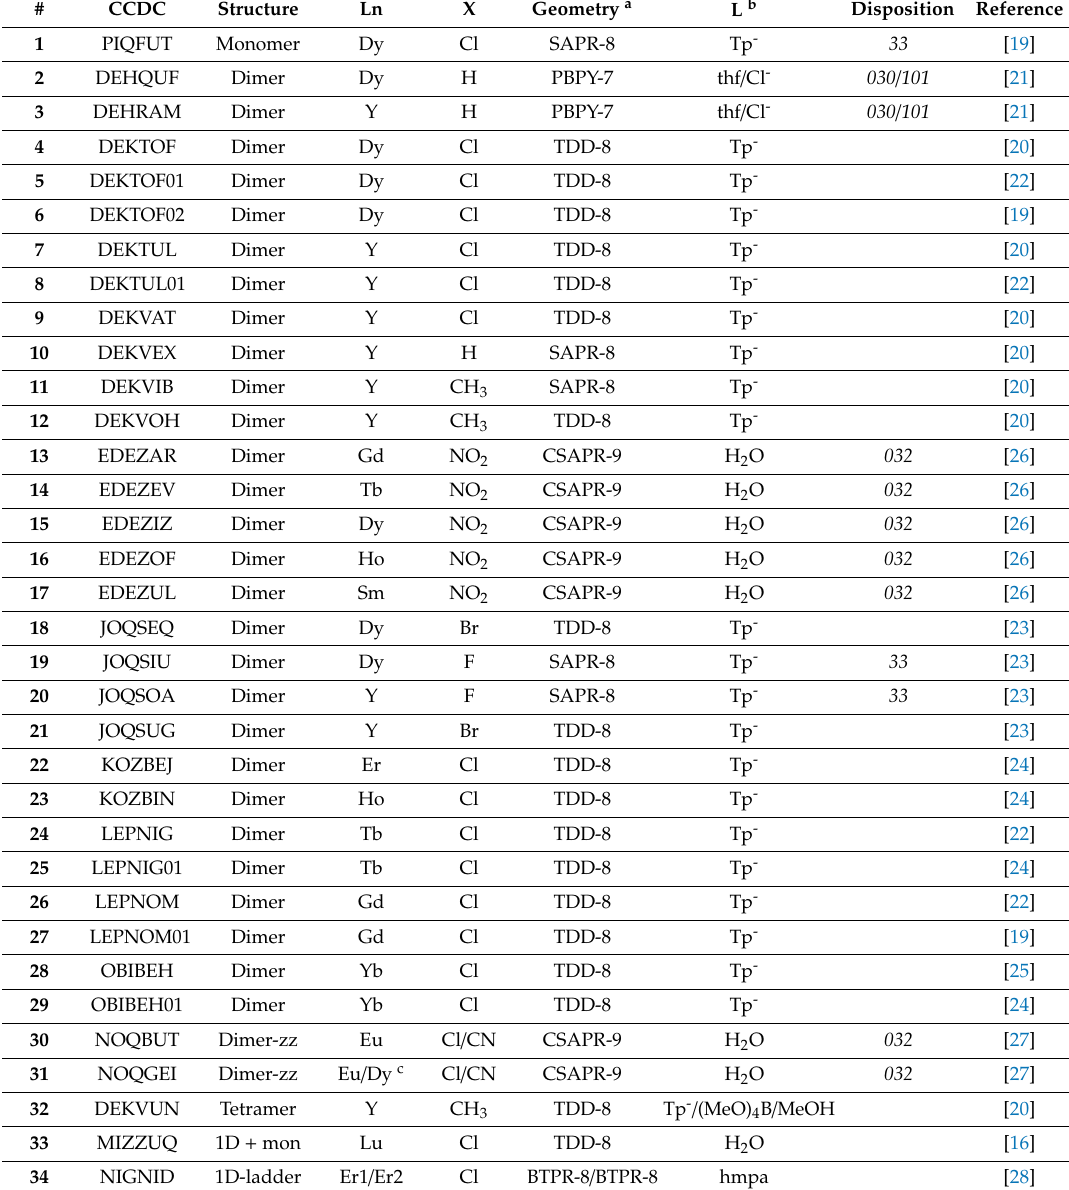
Table 1. Discrete ( 1 - 33 ) and 1D ( 33 and 34 ) Ln-anilato